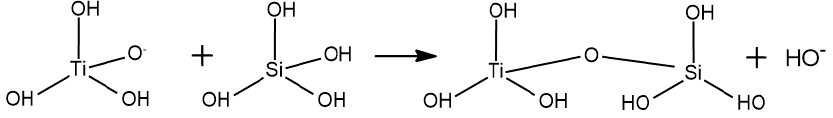
Figure A7. Hetero-condensation between Ti(OH) 4 and CA polymer molecules.